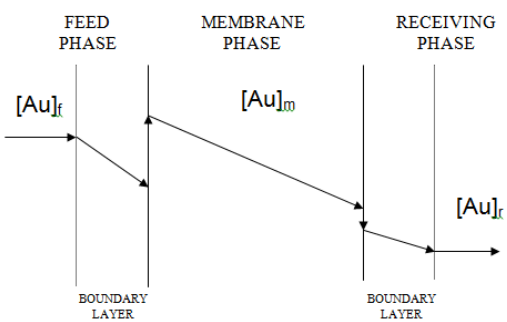
Figure 3. Gold profile in the supported liquid membrane (SLM)